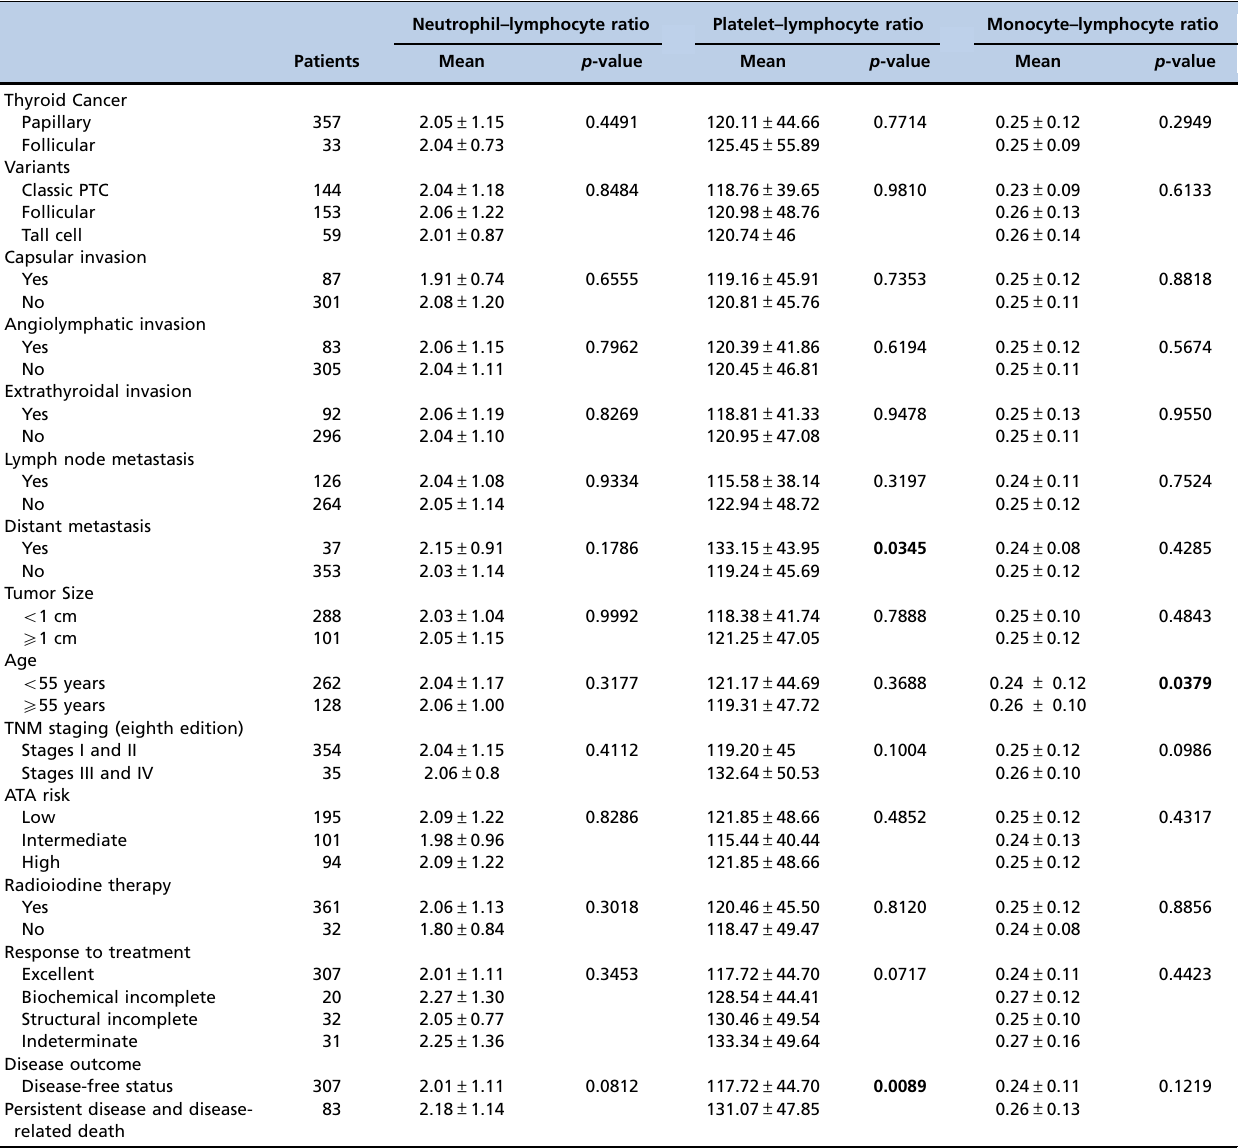
Table 2 - Association of neutrophil–lymphocyte ratio, platelet–lymphocyte ratio, and monocyte–lymphocyte ratio with tumor characteristics, stage, and evolution of differentiated thyroid carcinoma. Neutrophil–lymphocyte ratio Platelet–lymphocyte ratio Monocyte–lymphocyte